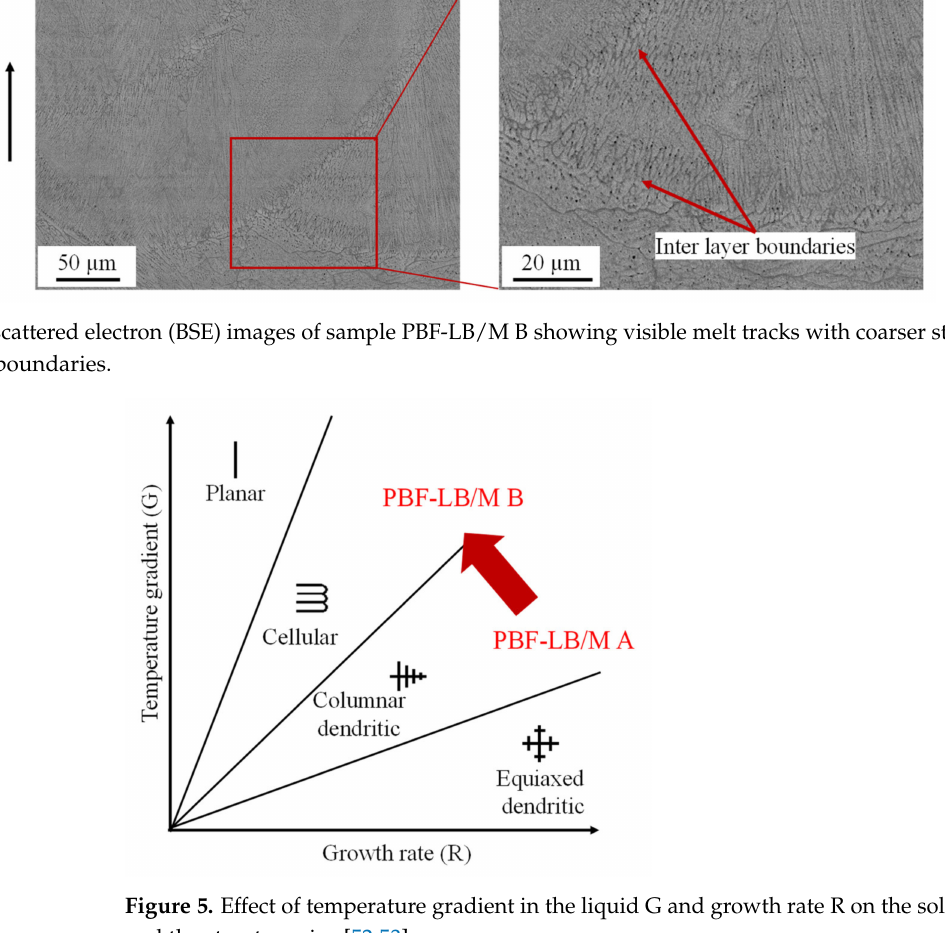
Figure 5. Effect of temperature gradient in the liquid G and growth rate R on the solidification mode and the structure size